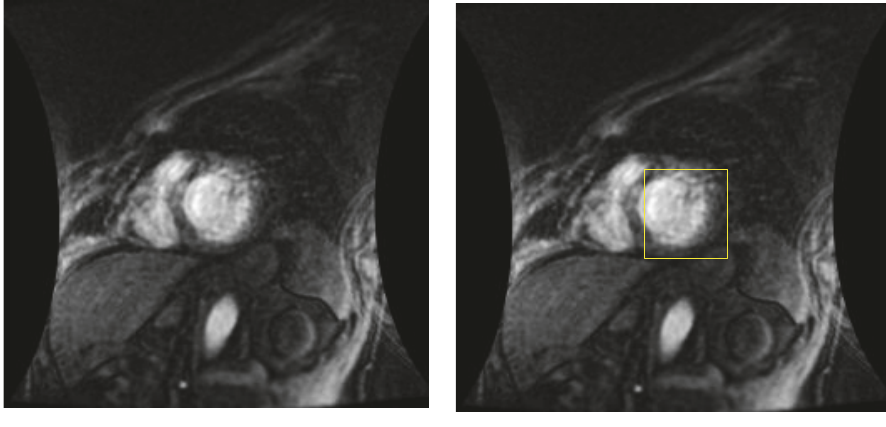
Figure 8: Detection outcome using the developed system (short axis image).